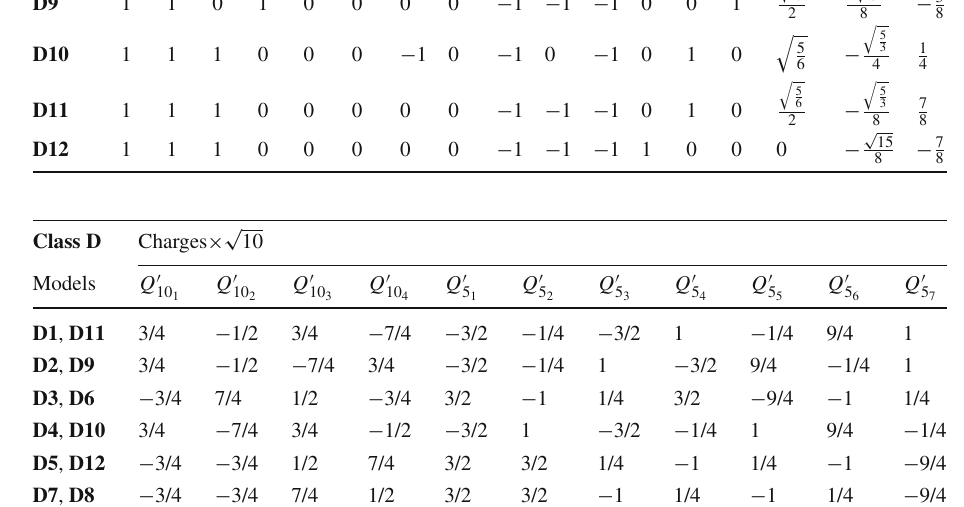
Table 17 U ( 1 ) (cid:2) charges of Class D models